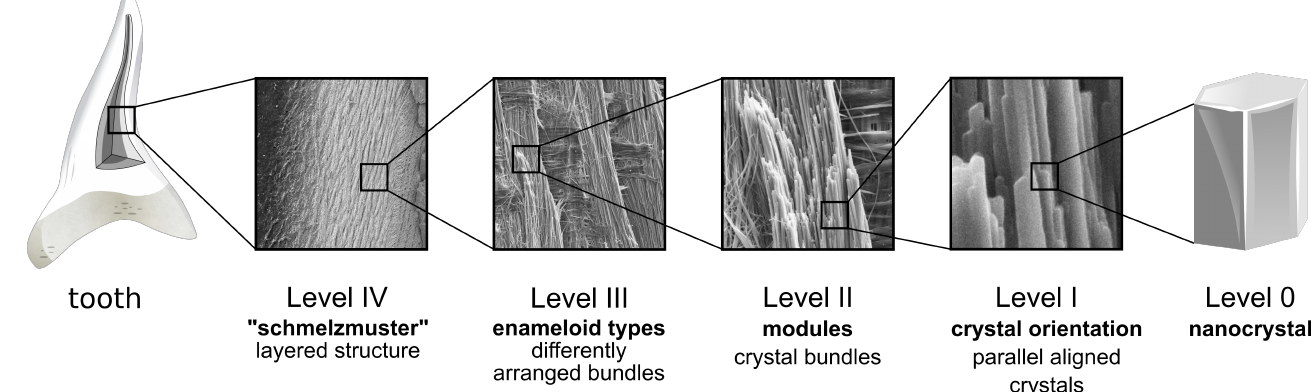
Figure 10. Structural hierarchy of shark teeth enameloid. The enameloid cover of an individual shark tooth exhibits a five-level hierarchical microstructure. On Level IV, the schmelzmuster , different structural patterns are combined to improve the biomechanical function of the tooth. These Level III patterns are the different enameloid types and consist of the Level II enameloid modules. In shark enameloid, the most common module is a bundle of parallel aligned crystallites (Level I). The lowest level of the hierarchy, Level 0, is the individual nanoscale